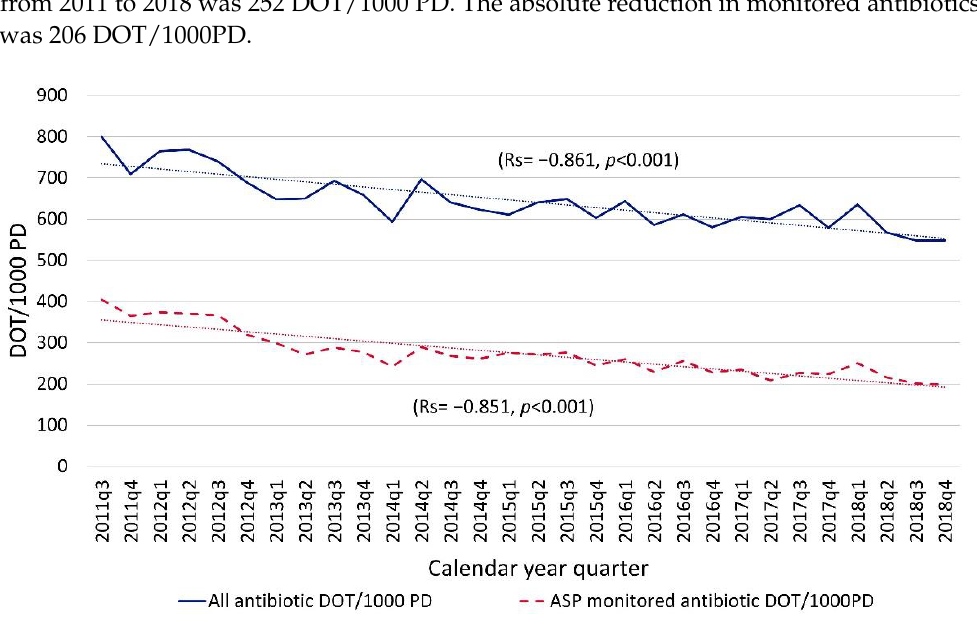
Figure 1. Quarterly antibiotic utilization for all antibiotics and antibiotics undergoing monitoring via PAF. Monitored antibiotics included meropenem, piperacillin–tazobactam, and cefepime, starting in 2013. Ceftriaxone, ceftazidime, cefotaxime, ciprofloxacin, levofloxacin, linezolid, and vancomycin were added at various time points after 2015. Spearman’s correlation (Rs) assessed trends over time. ASP, antimicrobial stewardship program; DOT, days of therapy; PD, patient days. Quarterly broad-spectrum antibiotic (e.g., meropenem, cefepime, piperacillin/tazo-